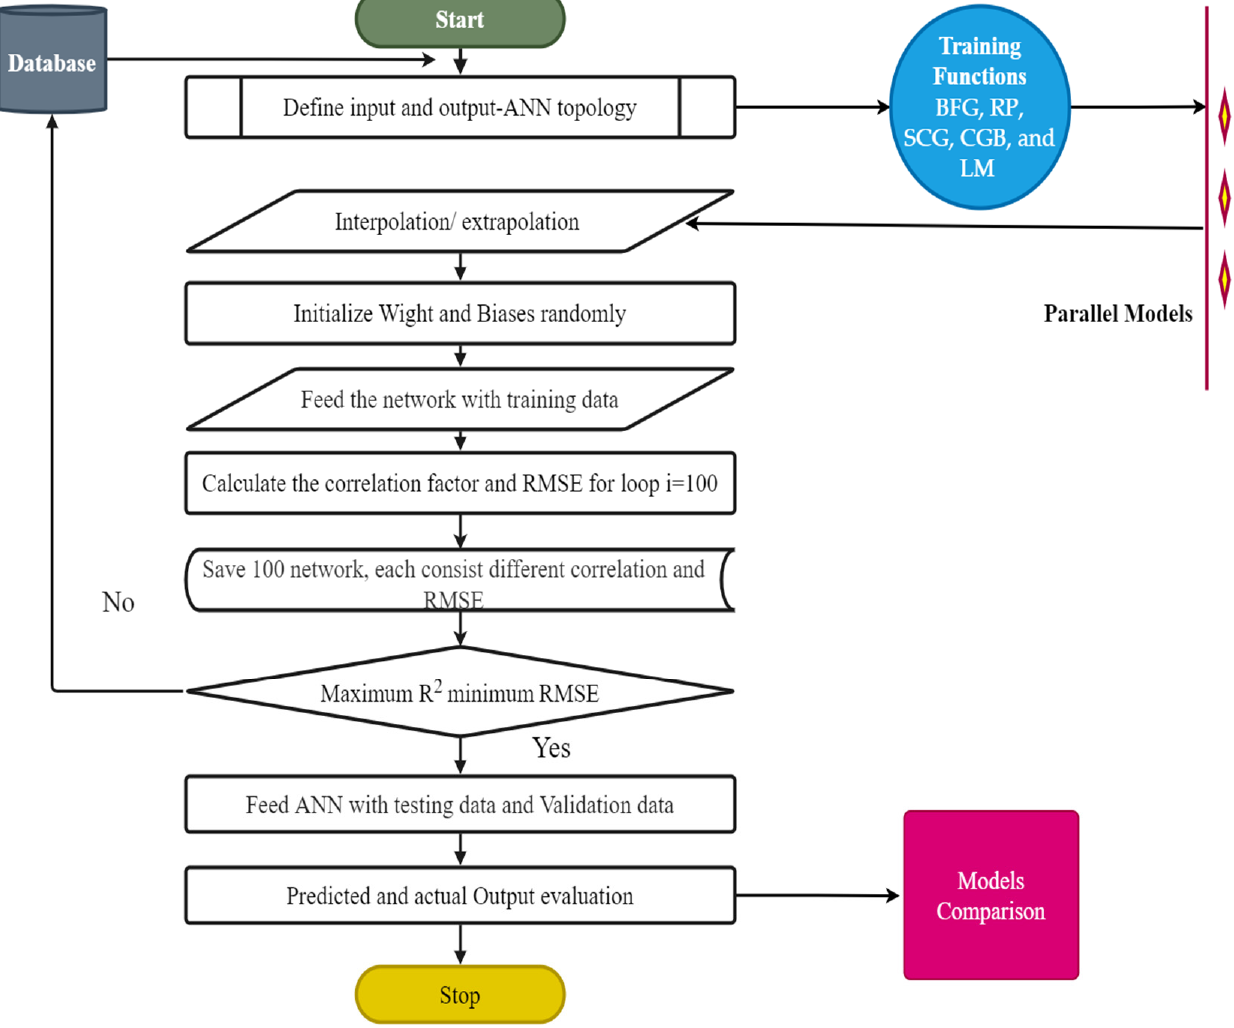
Figure 4. Flowchart of ANN for thermal damage model prediction.